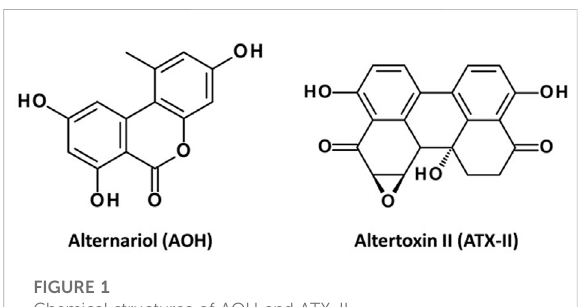
FIGURE 1 Chemical structures of AOH and